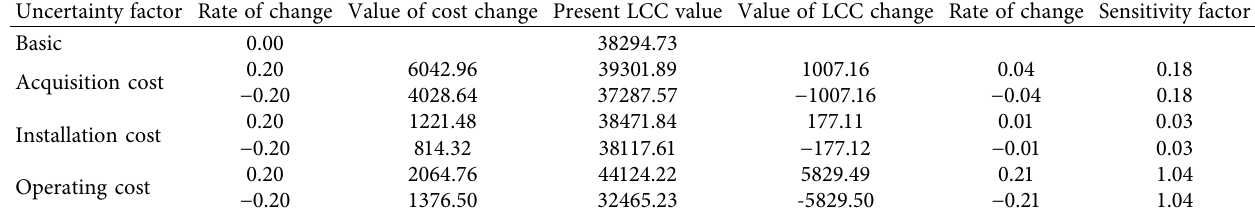
Table 9: Changes in the present value of Option 2 (million